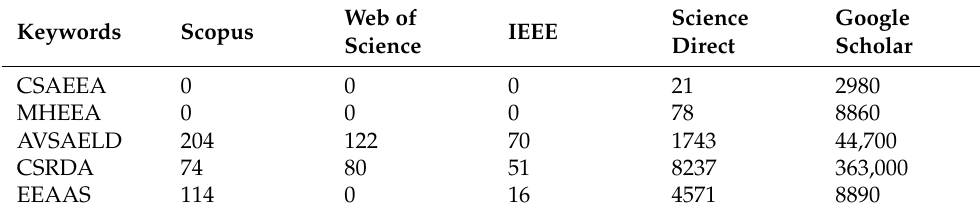
Table 2. List of Results for Keywords in Literature